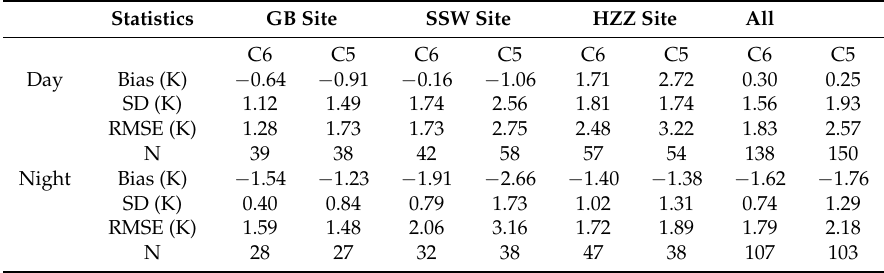
Table 3. Summary of the evaluation results of MODIS C5 and C6 1-km LST products obtained from the Terra satellite at three